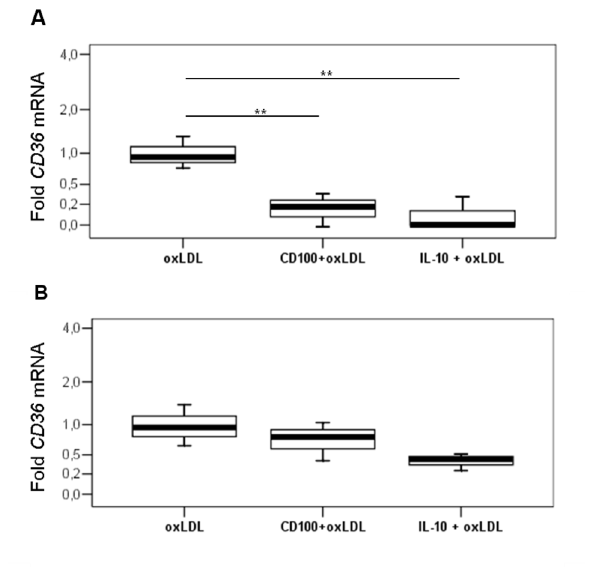
Figure 8. (A, B): CD36 mRNA is reduced in cultured macrophages treated with oxLDL in the presence of CD100 and IL-10. Relative quantitative RT-PCR (qRT-PCR) for CD36 in macrophages ( A ) and foam cells ( B ) incubated with oxLDL in the presence of CD100 or IL-10. Data normalized with GAPDH and expressed as a ratio (fold) relative to cells incubated only with oxLDL. Mean ± SD of 3 independent experiments (** p≤0.01).